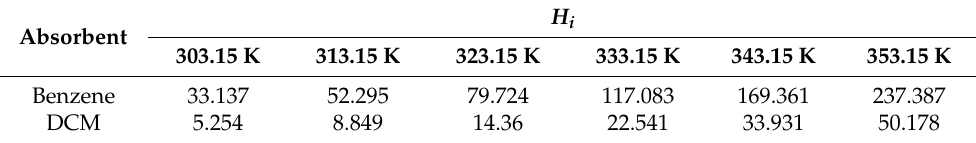
Table 4. Henry’s law constants ( Hi ) for DCM and benzene in [HMIM][Cl].